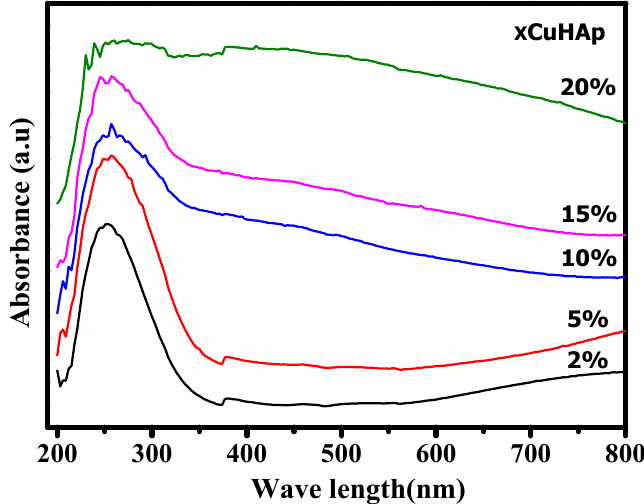
Figure 3. UVDRS spectra of CuHAp catalysts with different Cu loadings.